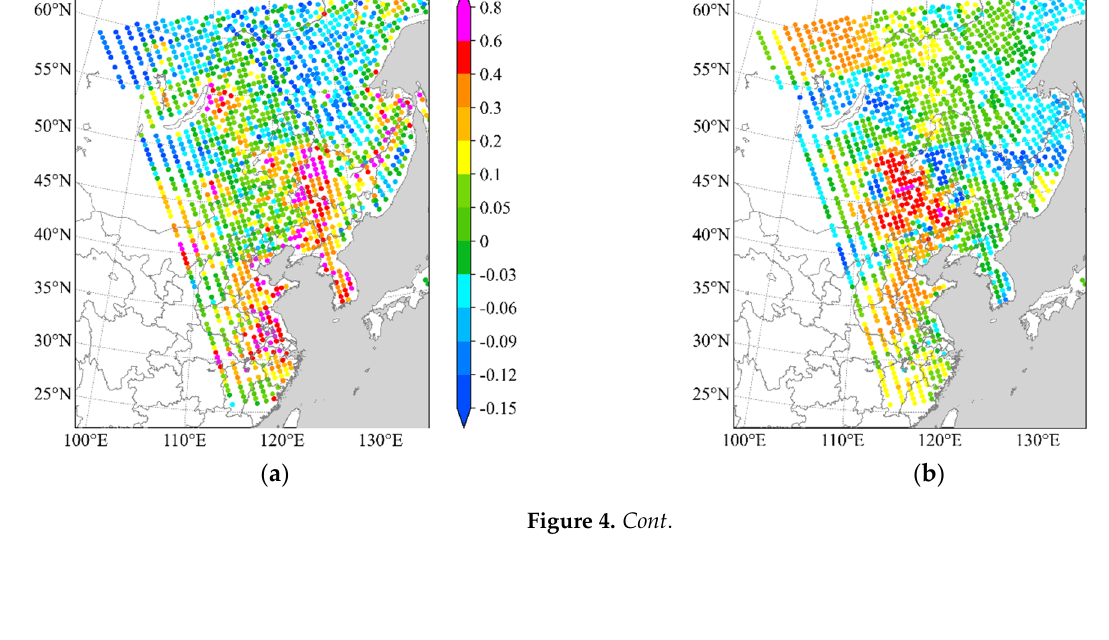
( c ) Figure 4. Same as in Figure 2a but for the spatial distribution of the ( a ) numerator, ( b ) denominator, and ( c ) AMSU-A cloud index.